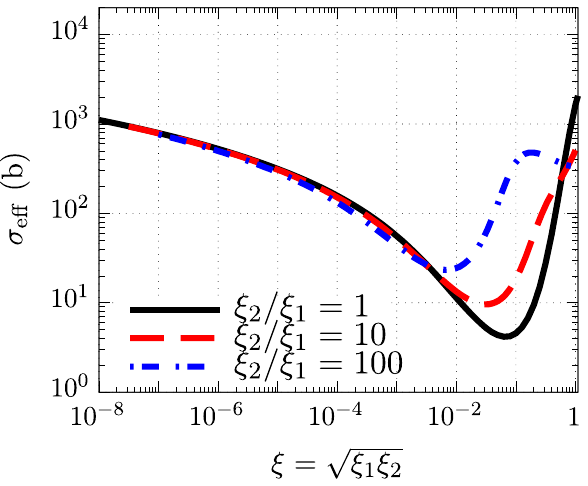
Fig. 3 The DPS effective cross section as a function of